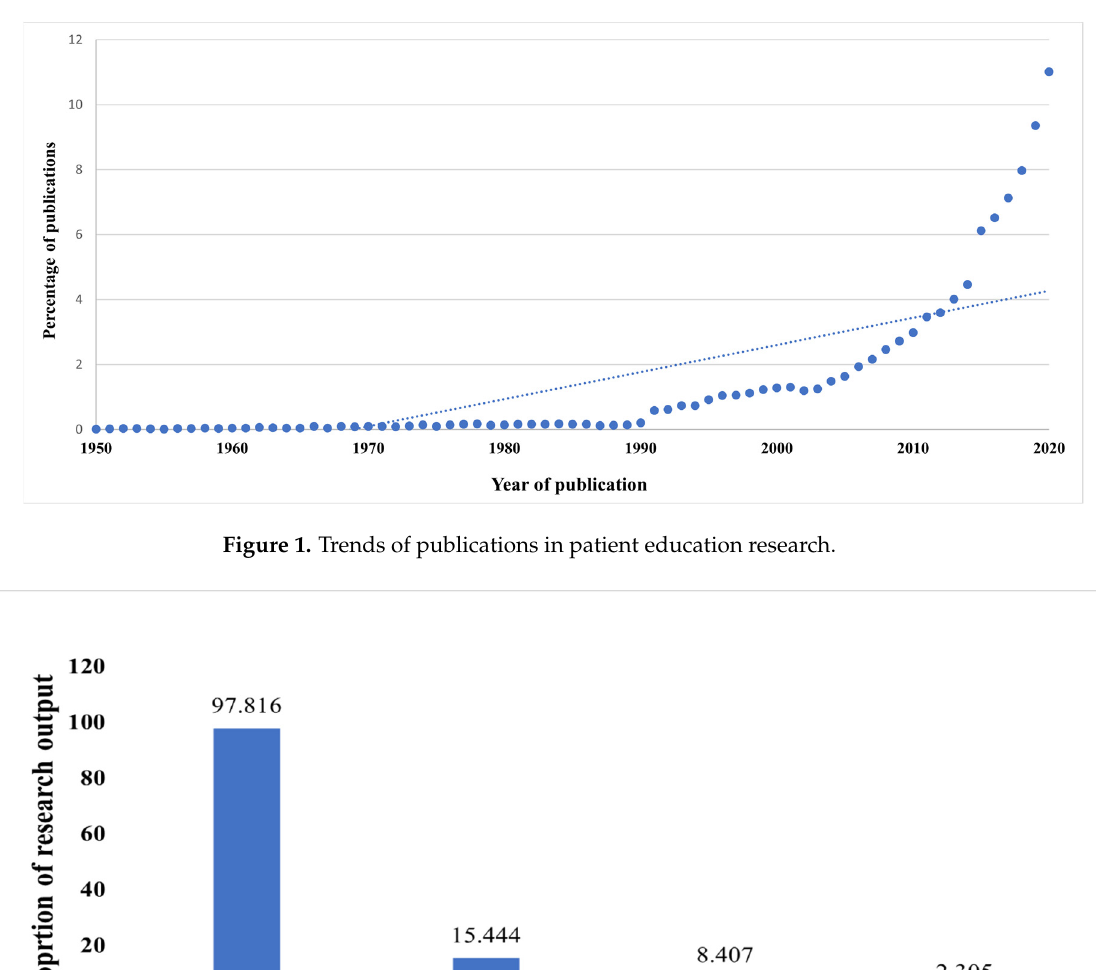
Table 2. Top-five stakeholders in patient education research.